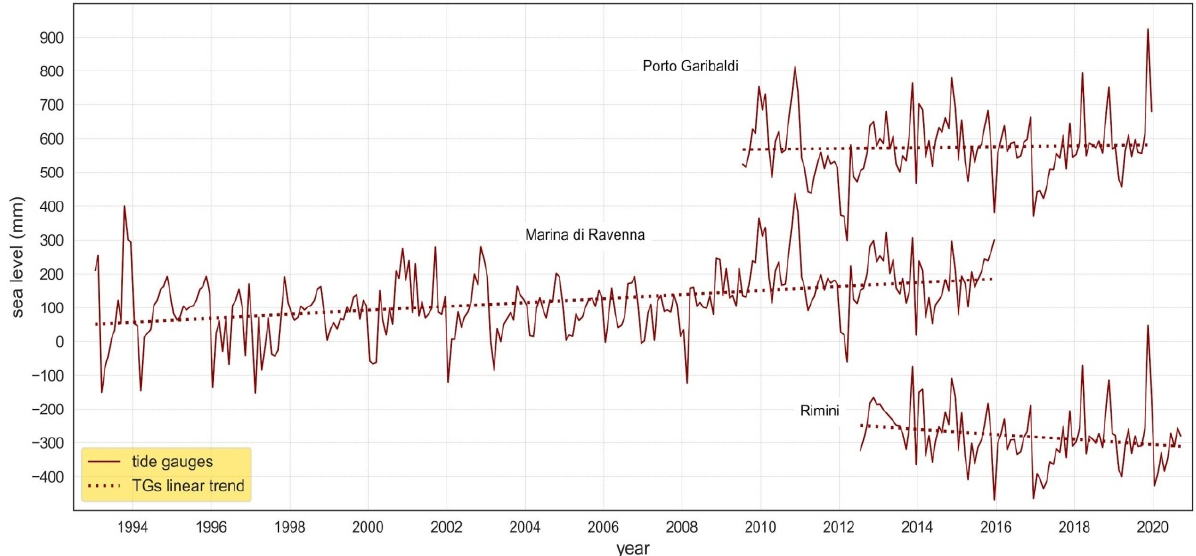
Figure A1. Raw TG time series. Dotted lines represent estimated linear models resulting from OLS regression. The offsets between the time series are arbitrary for better readability.